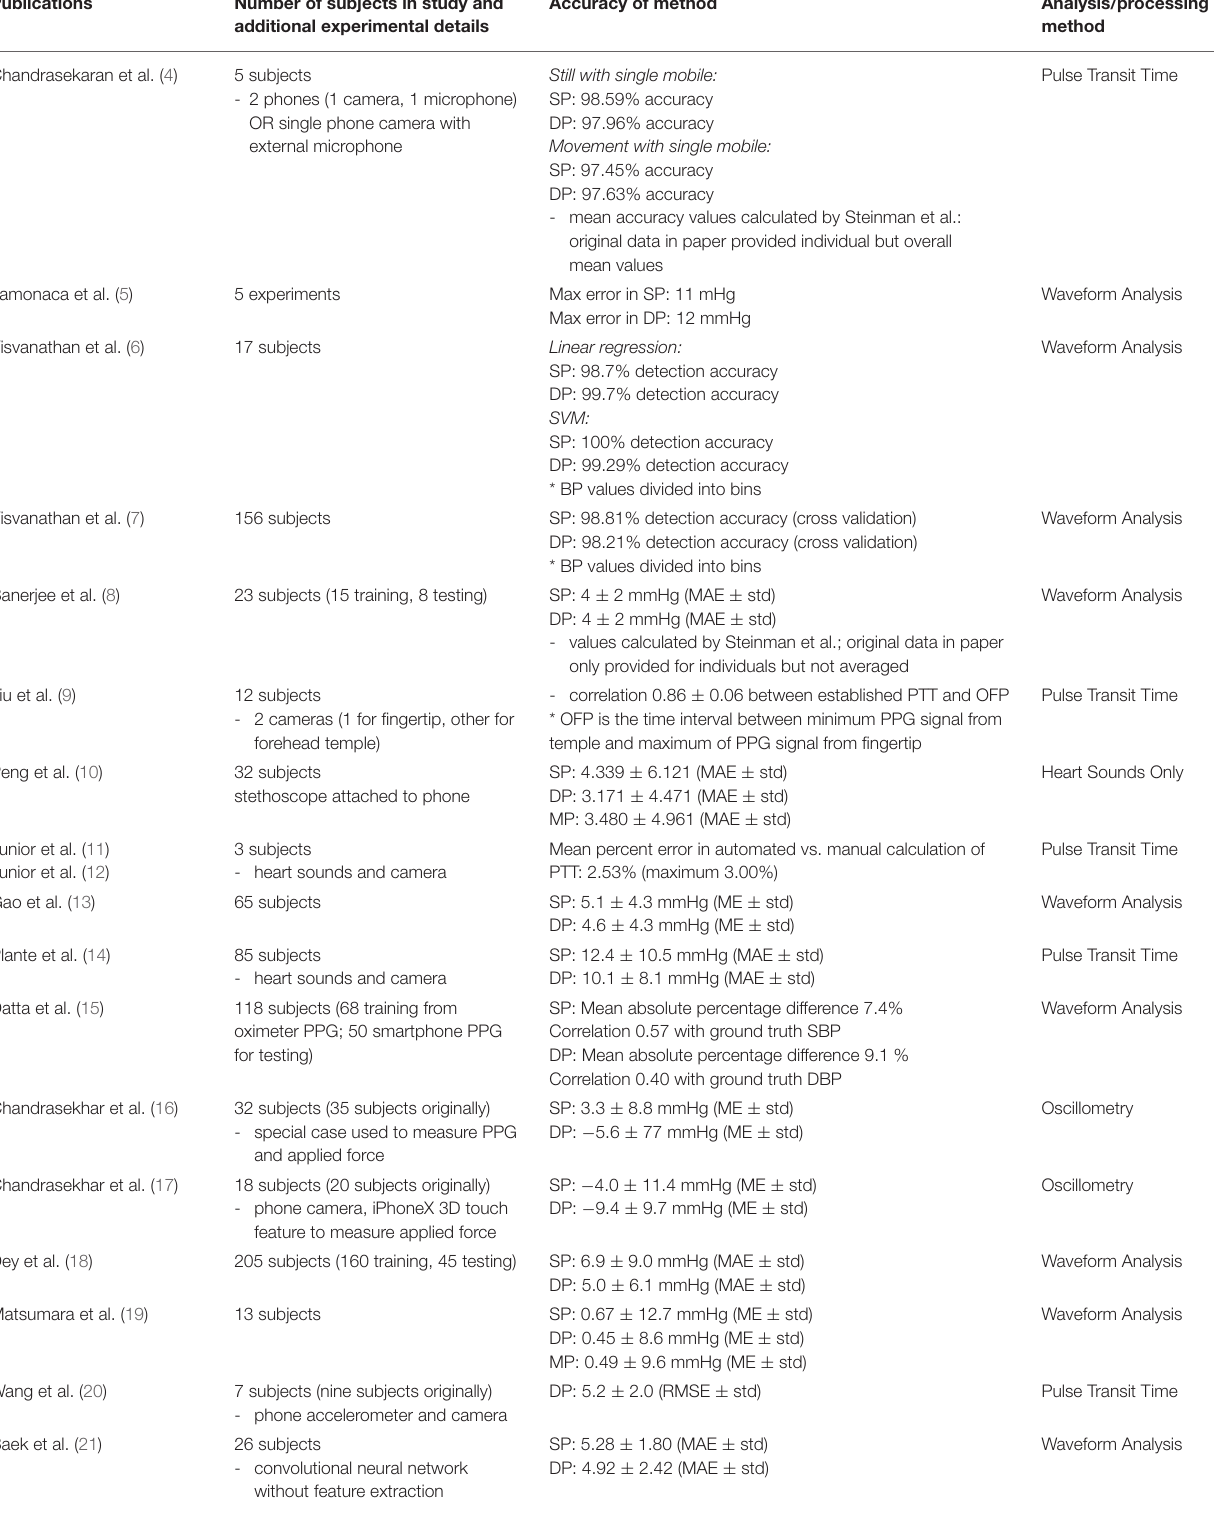
TABLE 1 | Contact methods for smartphone blood pressure (BP)